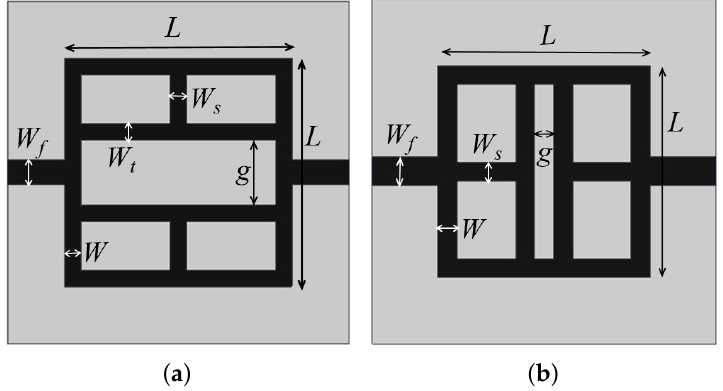
Figure 7. Geometry of the last two sensors realized with closed loop resonators and stubs tips of the same square resonator side length: ( a ) perpendicular ( b ) parallel to microstrip feeding line.